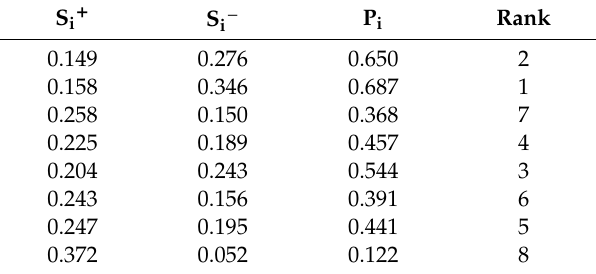
Table A10. Full calculations of the successfulness